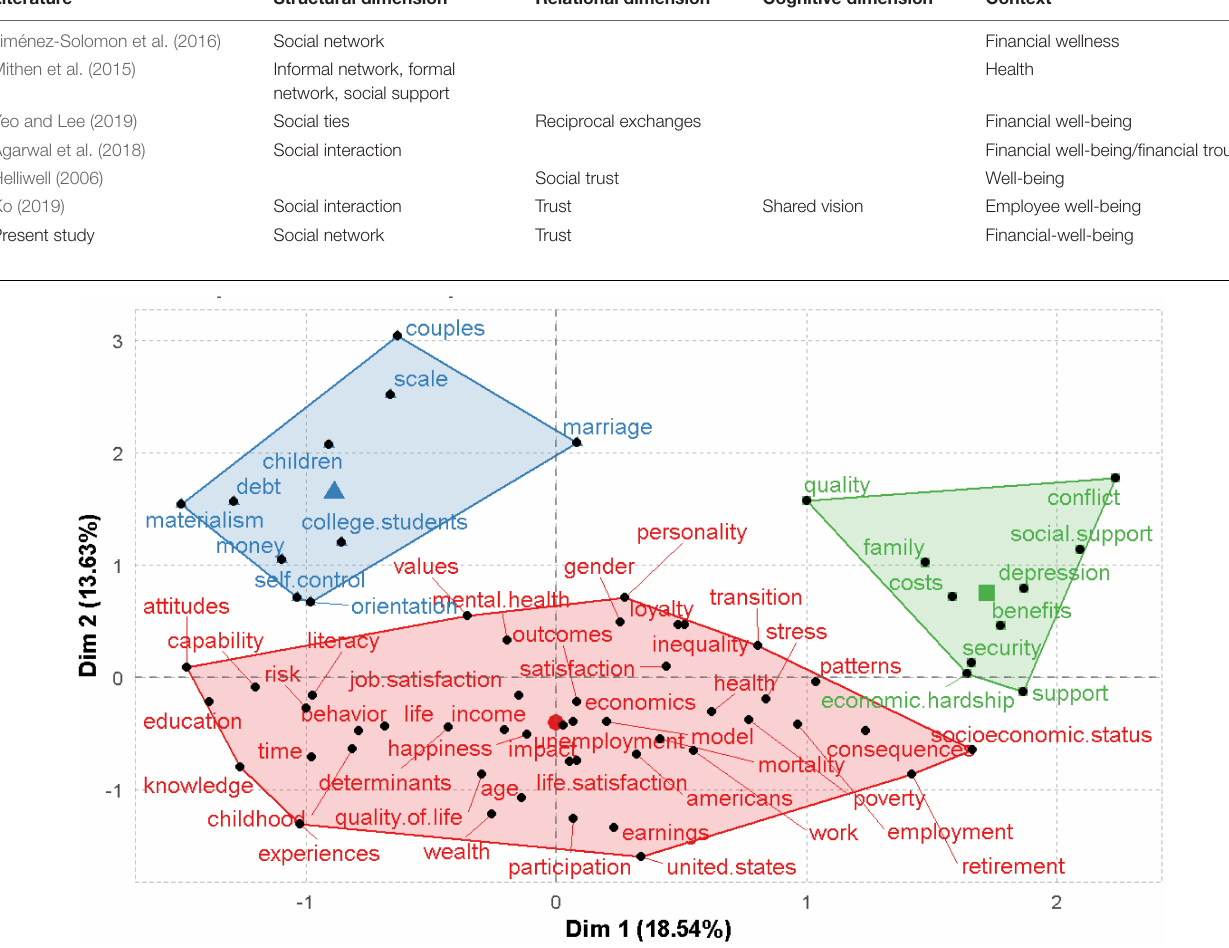
FIGURE 9 | Conceptual structure (method: multiple correspondence